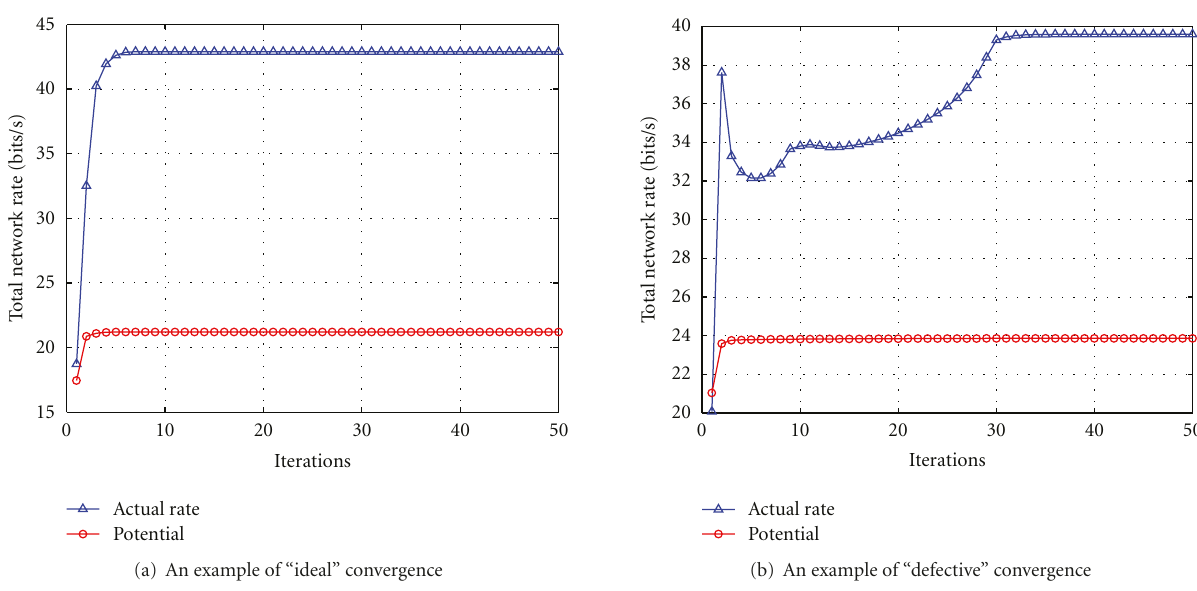
Figure 3: Convergence and performance of potential function and actual total network